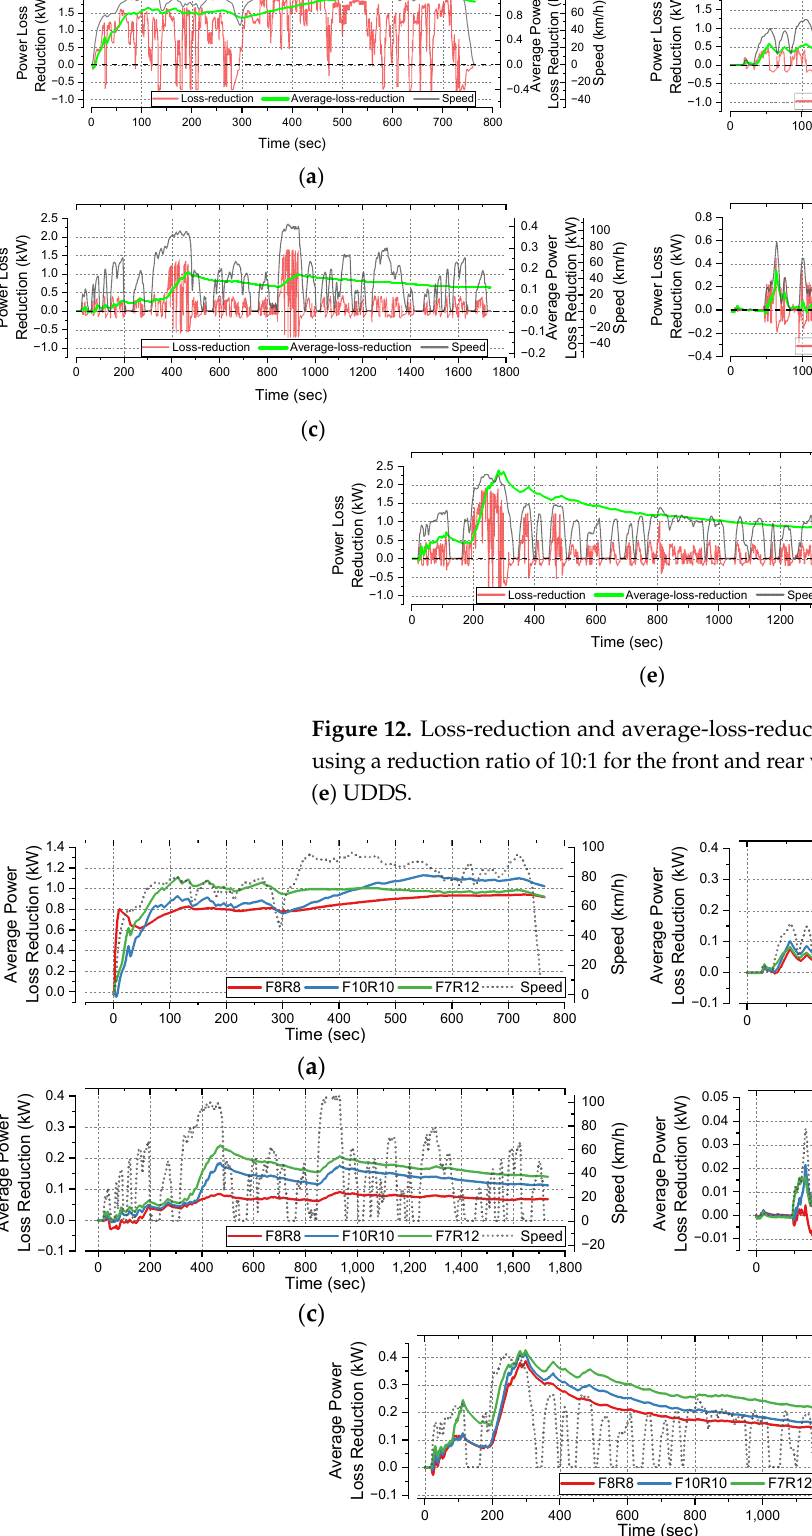
Figure 13. Average power loss reduction of the motor according to the gear ratio configuration: ( a )